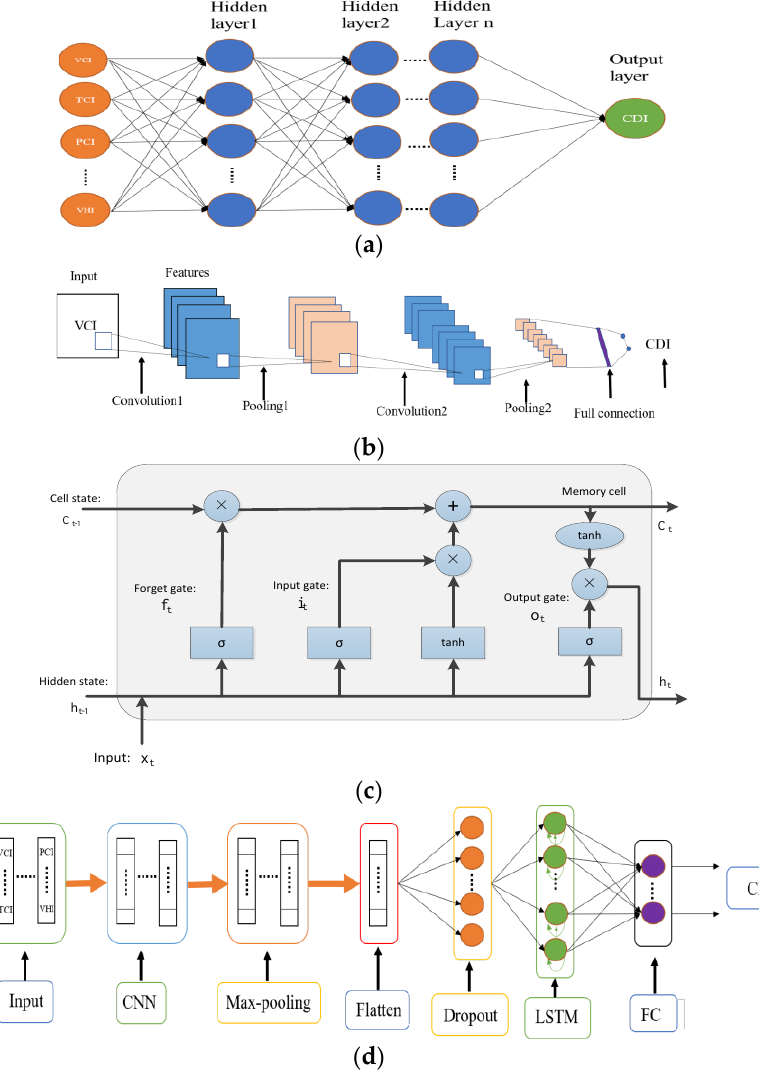
Figure A1 . ( a ) Architecture of the DFNN model used in this study; ( b ) CNN model architecture; ( c ) architecture of the LSTM model; and ( d ) overall structure of the ConvLSTM network.